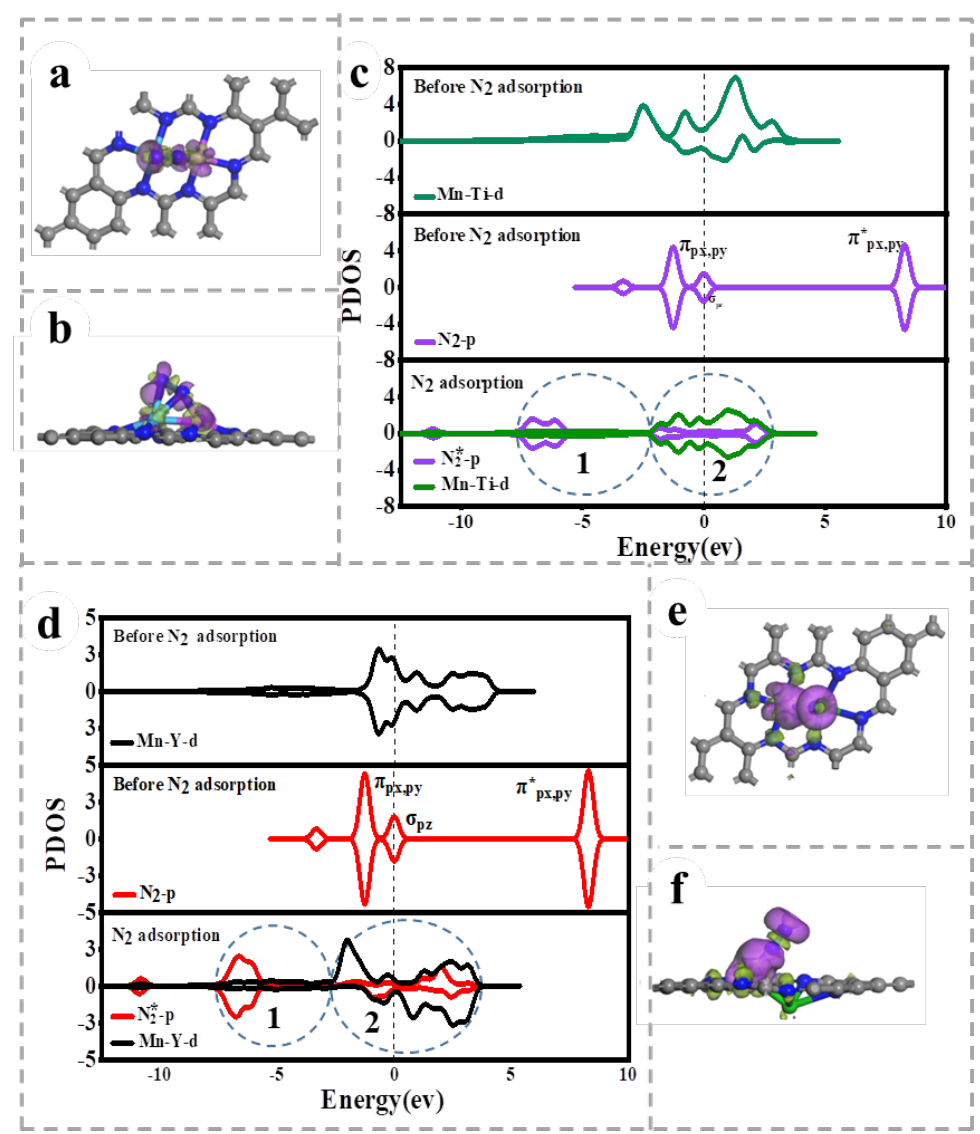
Figure 5. ( a , b ) N 2 differential plot of charge density adsorbed on Ti-Mn@N 6 -C; The purple and yellow surfaces represent the enrichment and depletion of electrons, respectively; ( c ) The PDOS of p -orbital of free (N 2 - p ) and adsorbed (N 2 *- p ) N 2 molecule, d -orbital of Mn and Y atoms (MnY- d ) on Mn-Y@N 6 -C before and after N 2 adsorption; ( d ) The PDOS of p-orbital of free (N 2 - p ) and adsorbed (N 2* - p )N 2 molecule, d-orbital of Mn and Ti atoms (Mn-Ti- d ) on Mn-Ti@N 6 -C before and after N 2 adsorption; ( e , f ) the CDD of N 2 adsorbed on Y-Mn@N 6 -C. The purple and yellow surfaces represent the enrichment and depletion of electrons, respectively.